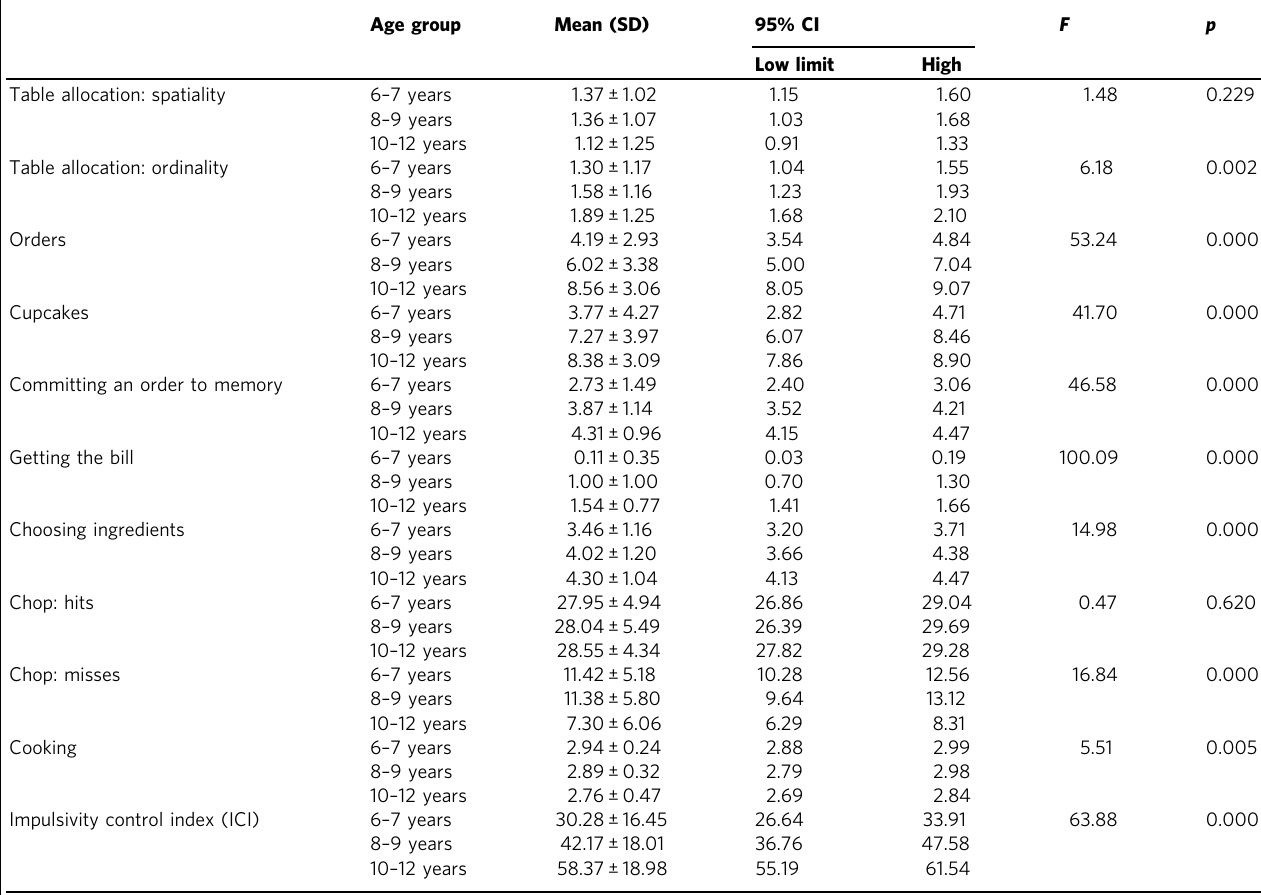
Degrees of freedom for all comparisons = 2,26.